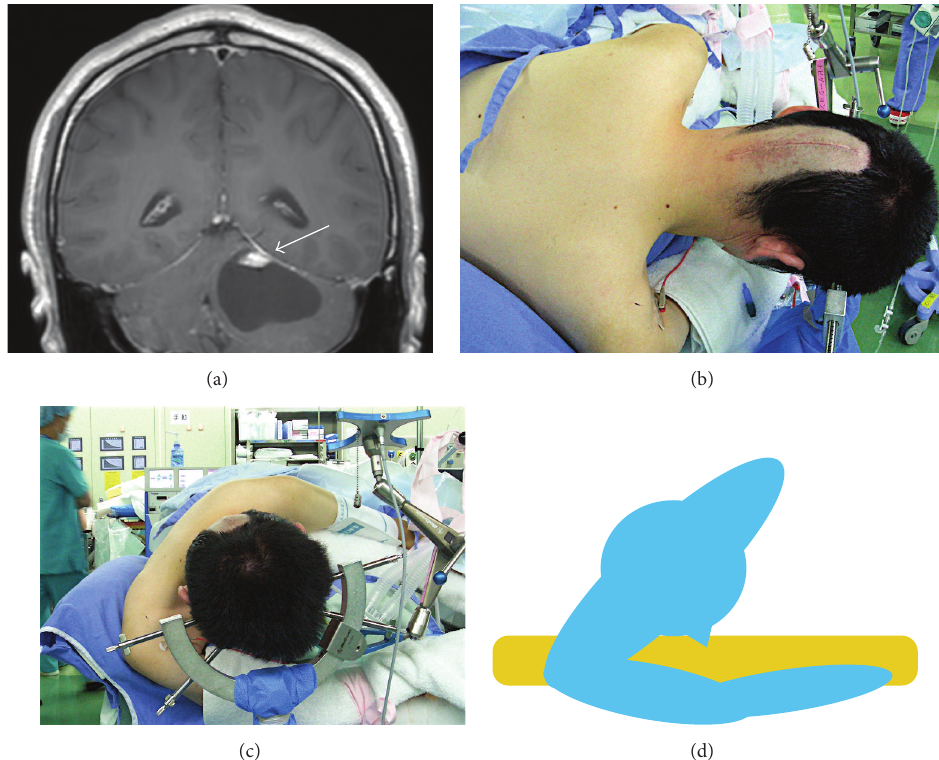
Figure 1: (a) Coronal image of preoperative MRI shows the tumor with cystic lesion on the left middle cerebellar peduncle (arrow). (b) Operative position was right lateral-semiprone position with chin down. (c) The right arm of the patient was placed in front of the neck to the left side and gently supported. (d) An illustrative diagram of the operative posture. Right submandibular lesion was caused by pressure being exerted on the face by this extreme